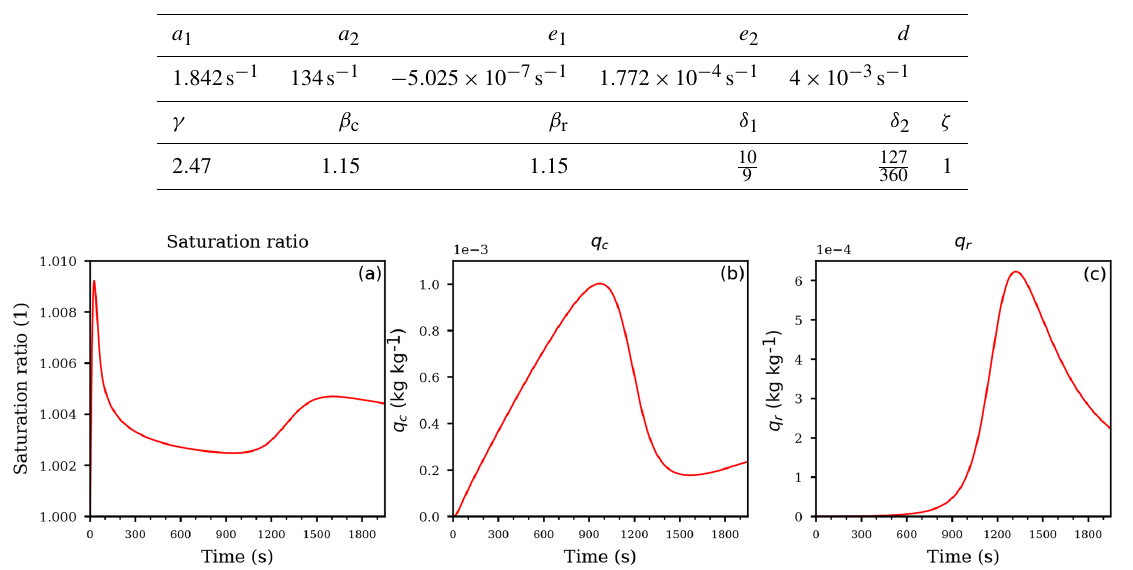
Table 1. Values of the coefficients and exponents used for the cloud scheme. All coefficients except for e 1 , e 2 are independent of environ- mental pressure and temperature. The values for the exponents are exact; the values for the coefficients are rounded to three digits. The coefficient values displayed for e 1 , e 2 are for environmental pressure 850hPa and temperature 270K.